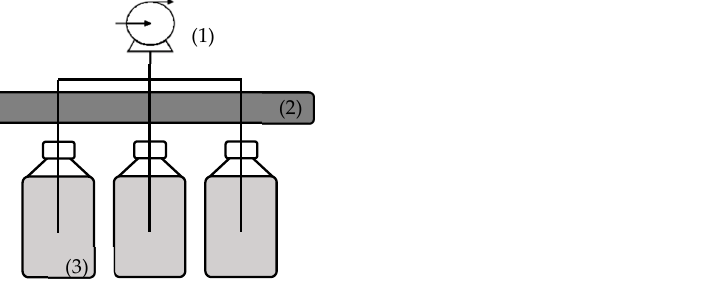
Figure 1. Schematic representation of the experimental setup: (1) air pump; (2) LED panel and (3) culture flasks.